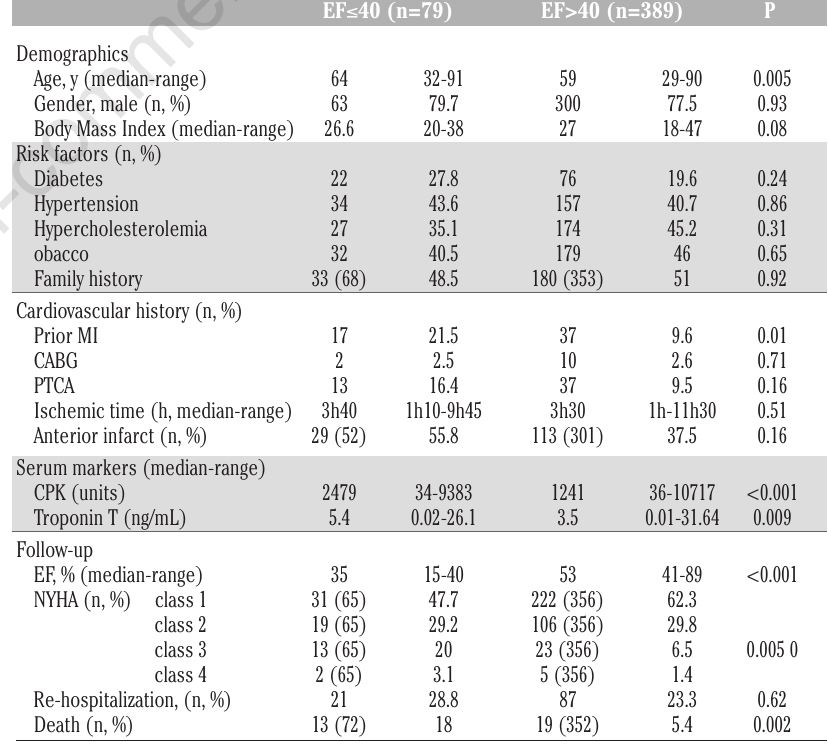
CABG, Coronary Artery Bypass Grafting; CPK, Creatine PhosphoKinase; EF, Ejection Fraction; MI, Myocardial Infarction; PTCA, Percutaneous Transluminal Coronary Angioplasty; NYHA, New York Heart Association class. When different from the total, available numbers of data are indicated in